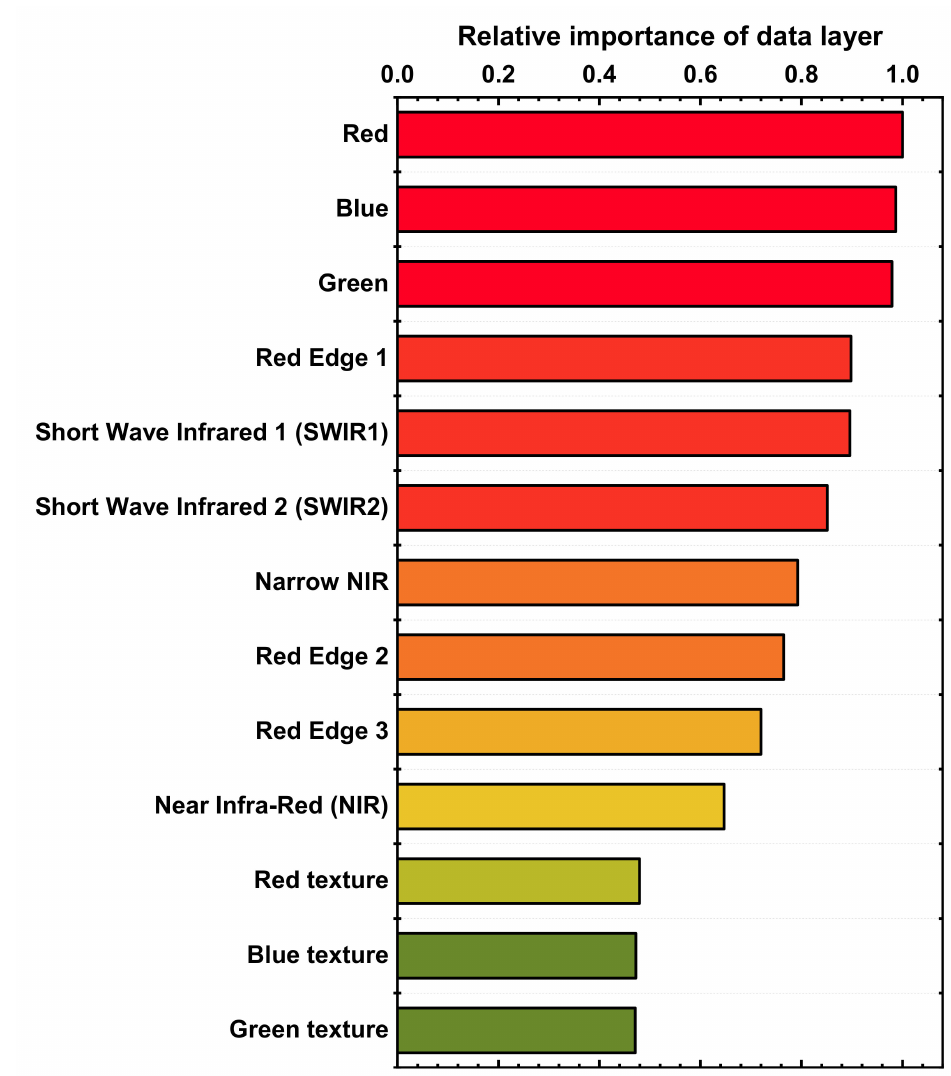
Figure 9. Data layer importance relative to the red band